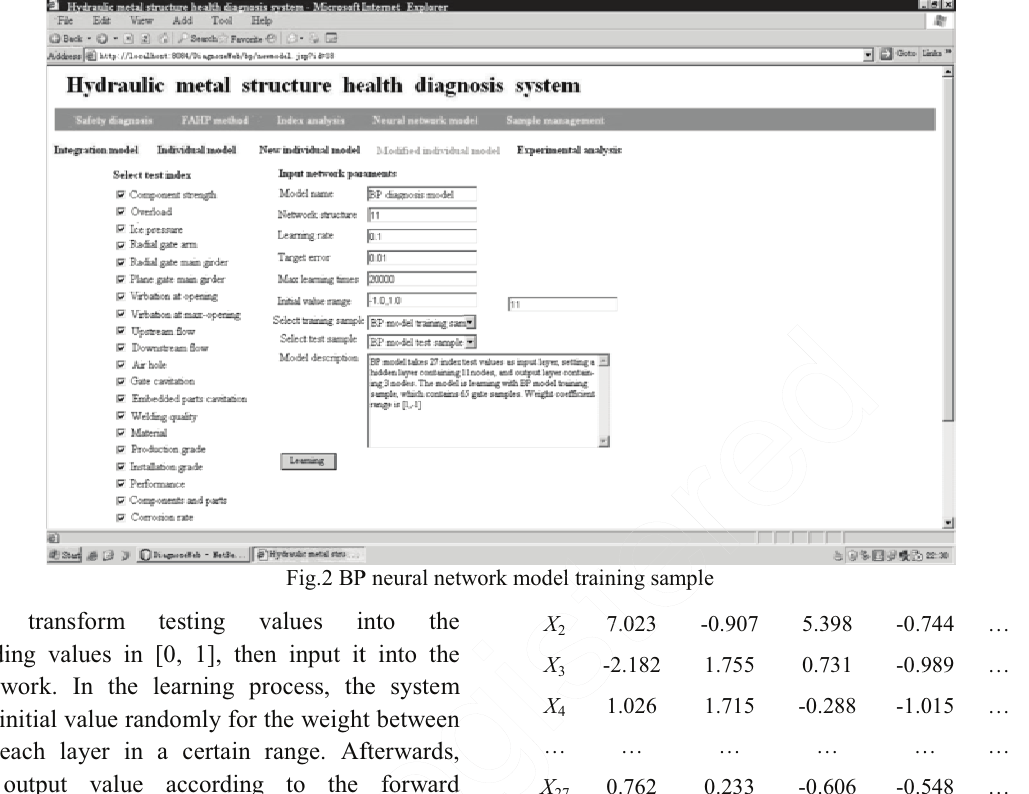
earning curve with and the vertical sults indicate that: ning process, the he training model network structure, ining samples, the eight of each layer is not